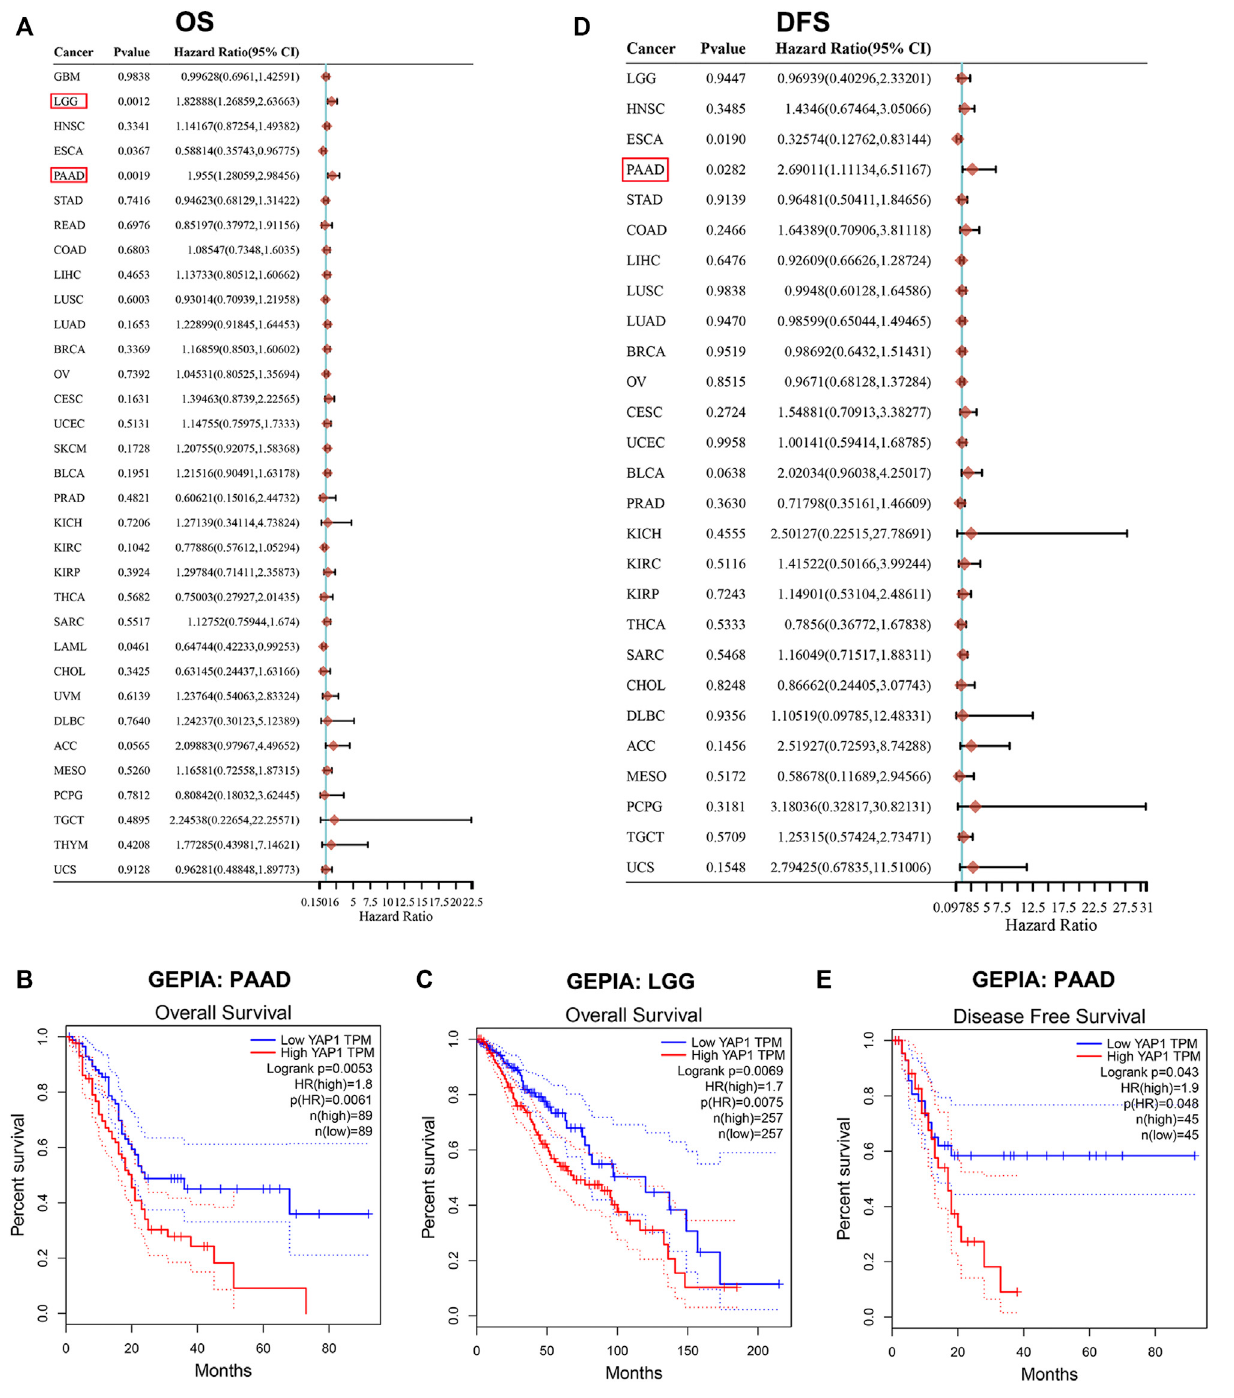
Frontiers in Genetics |